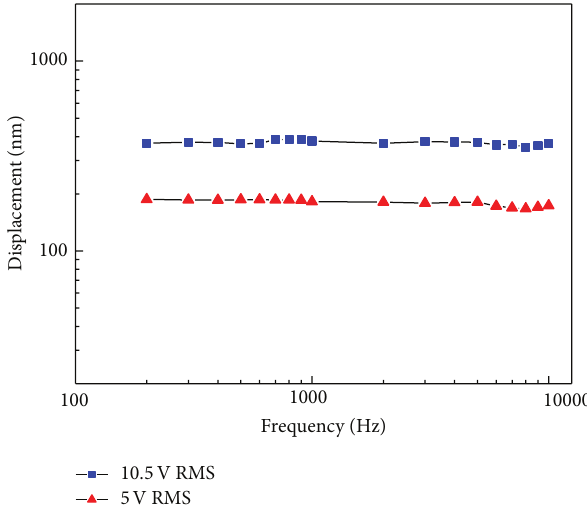
Figure 11: Vibration displacement of the piezoelectric